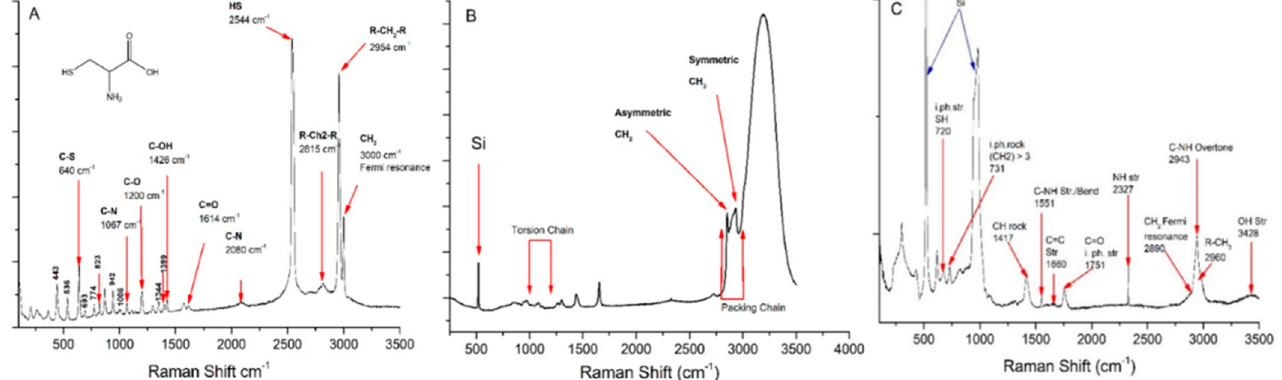
Figure 5. Raman spectrums. ( A ) Amino acid L-cysteine. ( B ) Oleic acid, ( C ) bioconjugated material of oleic acid and L-cysteine (MAT).